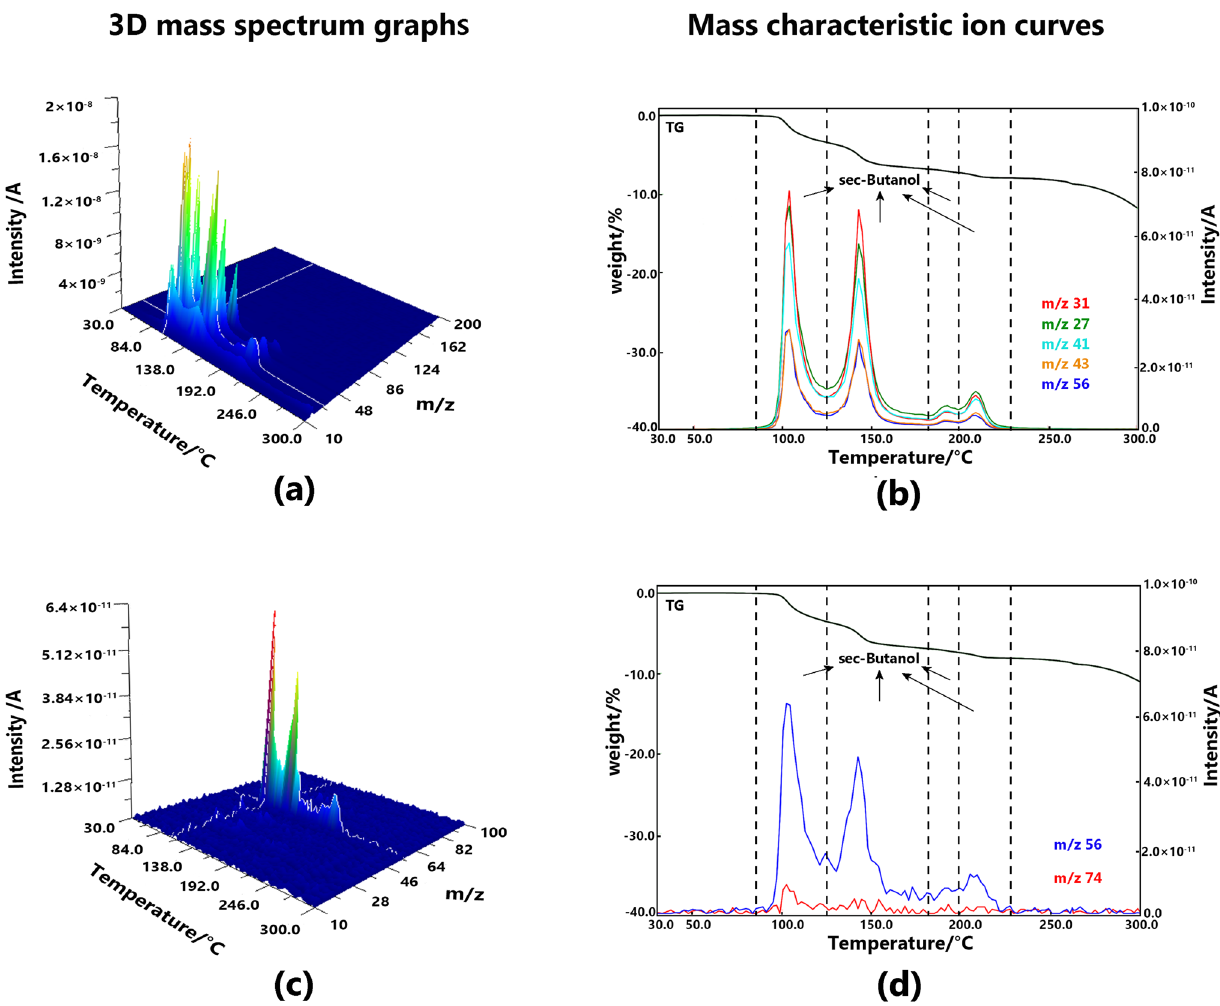
Fig. 4 3D mass spectrum graphs of solvatomorph B measured at EI method ( a ) and PI method ( c ), mass characteristic ion curves solvatomorph B measured at EI method ( b ) and PI method ( d